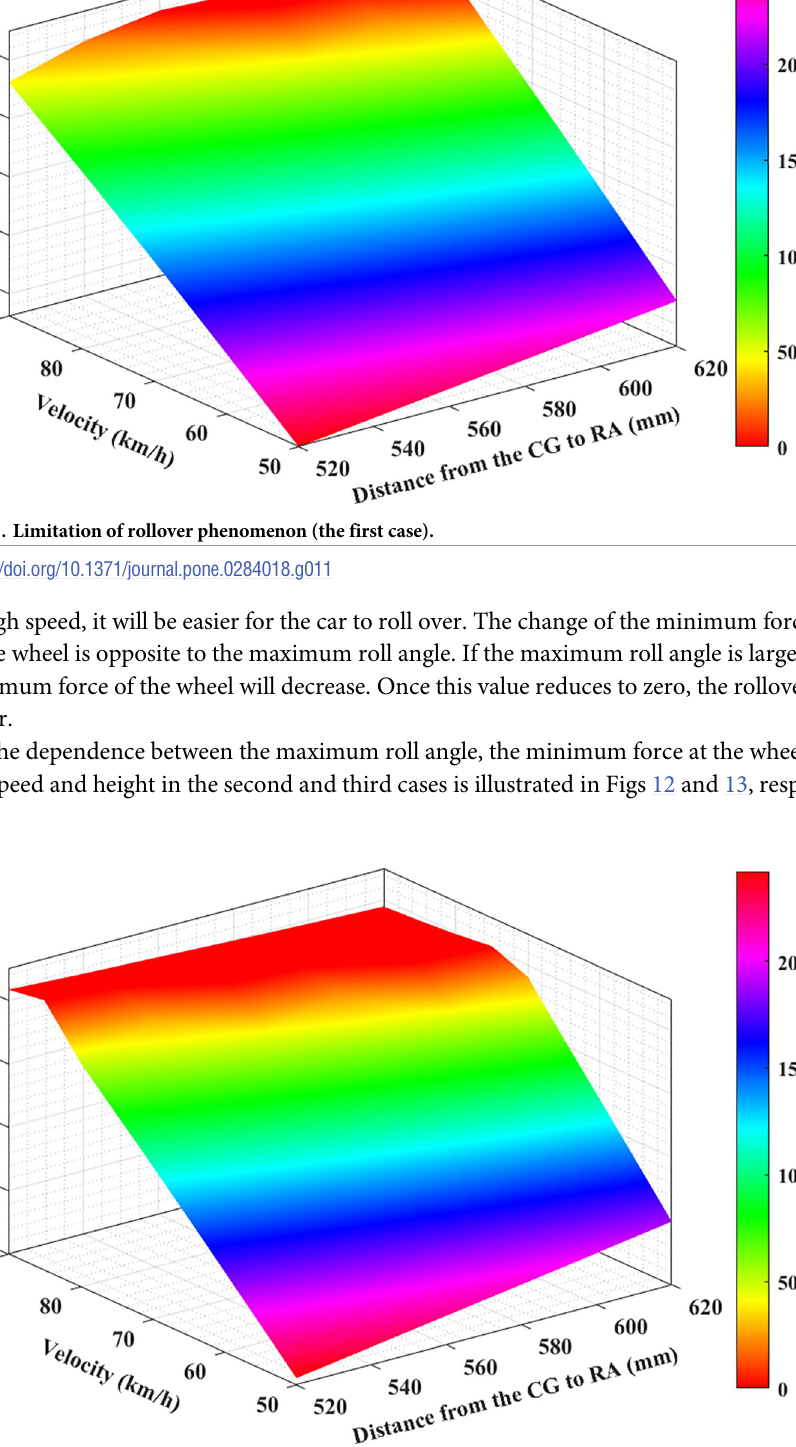
Fig 12. Limitation of rollover phenomenon (the second